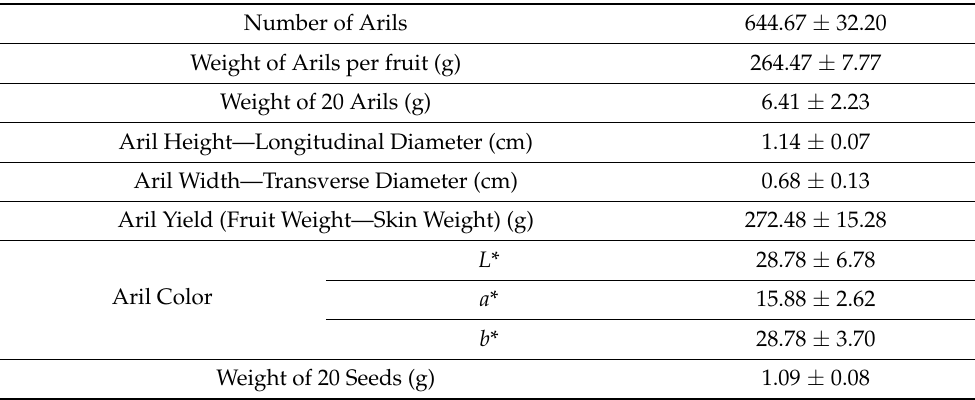
Table 2. Characteristics of the pomegranate arils prior to treatment and storage. Values are expressed as mean ± standard deviation (n = 10).